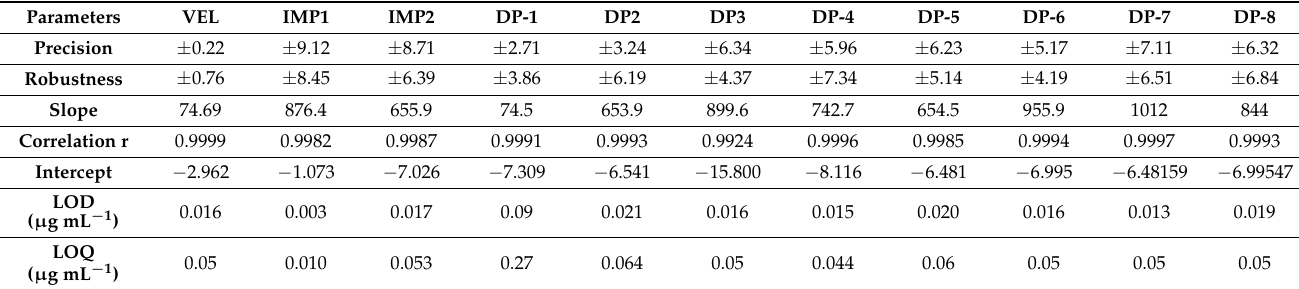
Table 3. Precision and linearity